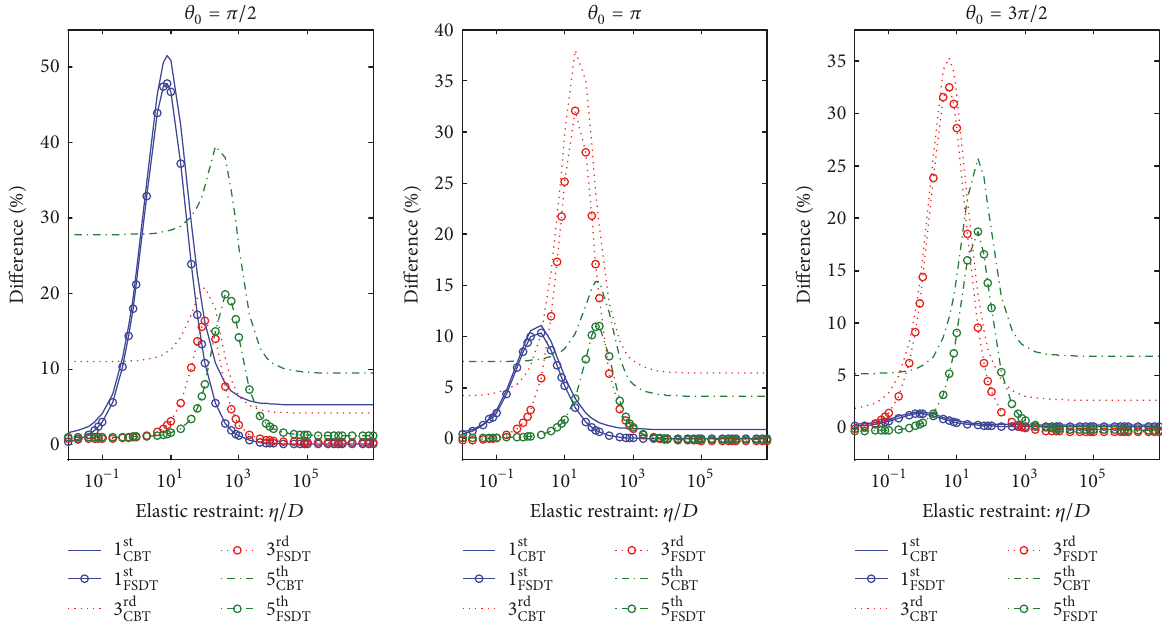
Figure 11: Relative deviations between frequency parameters Ω based on the CBT/FSDT theory models to those of 2D theory for elastically restrained circular beams with different restraint rigidities ( 𝜃 = 𝜃 0 : clamped; 𝜃 = 𝜃 1 : 𝑘 1 𝑢 = 𝜂 , 𝑘 1 𝑤 = 0